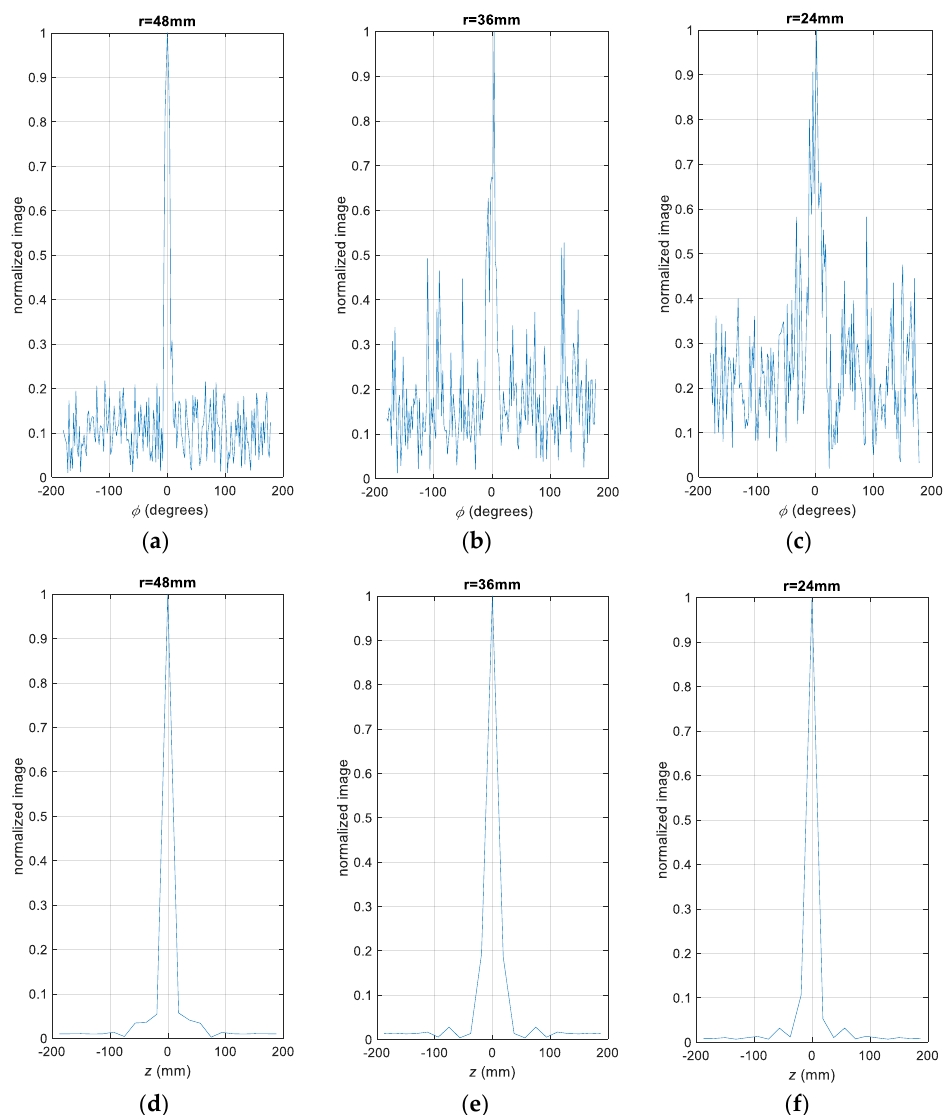
Figure 12. Depiction of 1D slices of 3D reconstructed images of a single object placed: ( a ) at 48 mm, slice along ϕ direction, ( b ) at 36 mm, slice along ϕ direction, ( c ) at 24 mm, slice along ϕ direction, ( d ) at 48 mm, slice along z direction, ( e ) at 36 mm, slice along z direction, ( f ) at 24 mm, slice along z direction.